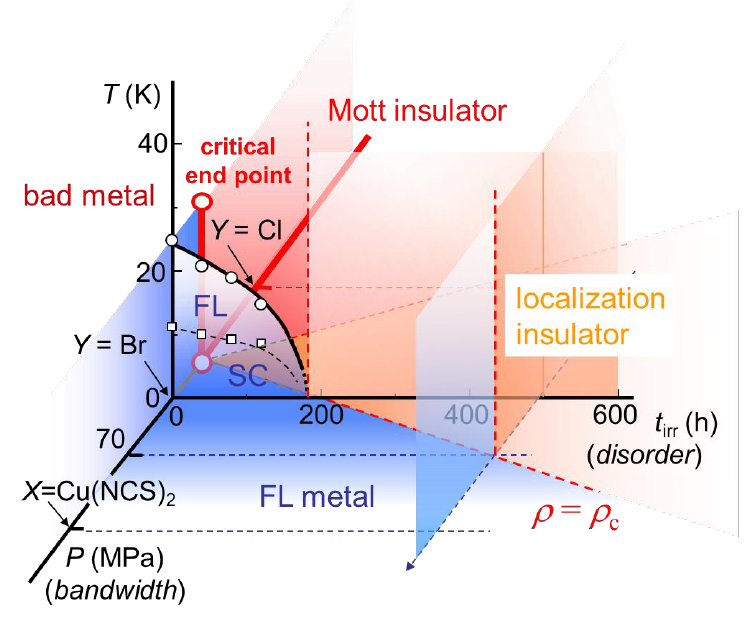
Figure 6. Schematic electronic phase diagram of κ-(BEDT-TTF) irradiation time t and pressure P . The thick dashed red lines indicate the critical resistivity irr ρ between the metal (FL) and the localization insulator. The temperature dependence of c the resistivity shows a T 2 dependence in the FL metal